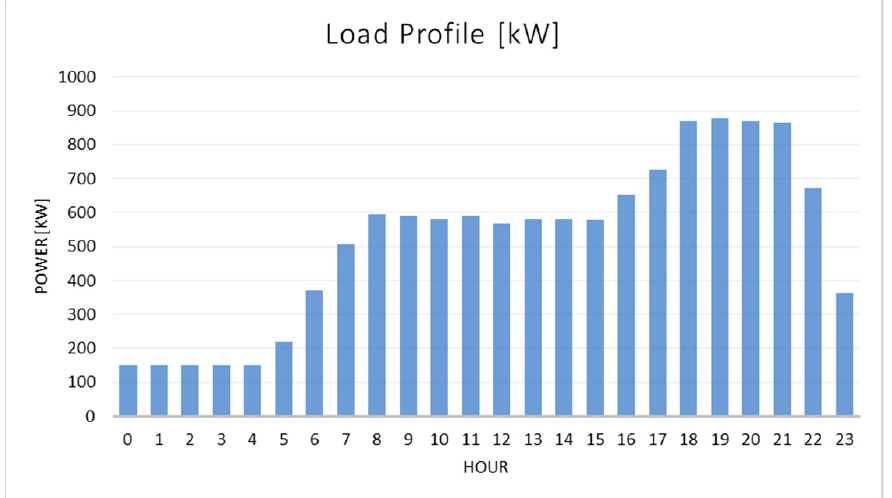
Figure 20. Load profile.